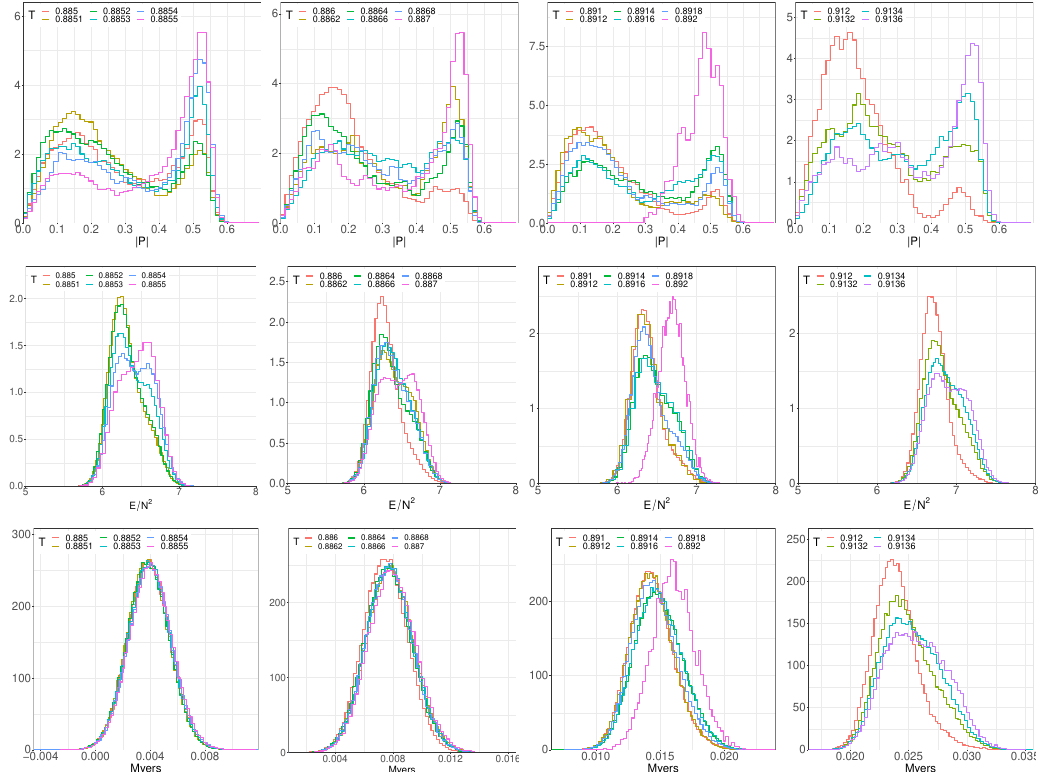
Figure 10. Histogram of the distribution of the Polyakov loop (first row), energy (second row), and Myers term (third row) during lattice Monte Carlo simulations for the bosonic BMN model at matrix size N = 64 and lattice size L = 24 . The values of µ are 0.125, 0.25, 0.5 and 1.0, from left to right. A two-state signal near the transition temperature is observed at all values of µ , particularly for the Polyakov loop P . The jumps of energy and Myers terms are of order N 2 , but we do not observe the formation of a fuzzy-sphere